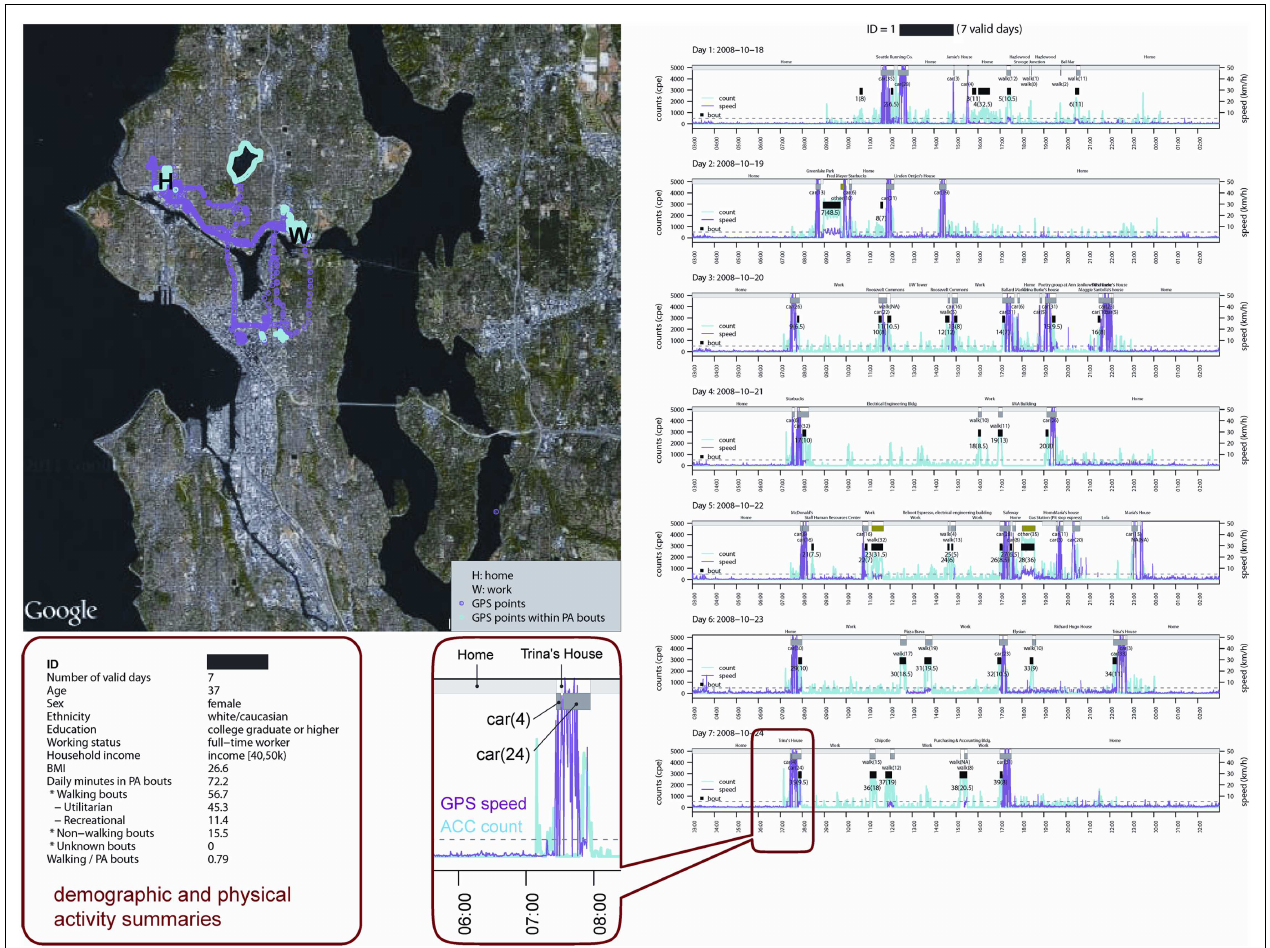
those that occurred within a physical activity bout in cyan, as well as home and work locations (“H” and “W” markers). A summary of demographic characteristics and overall subject-level activity, as well as a close-up of graph data, are shown in the